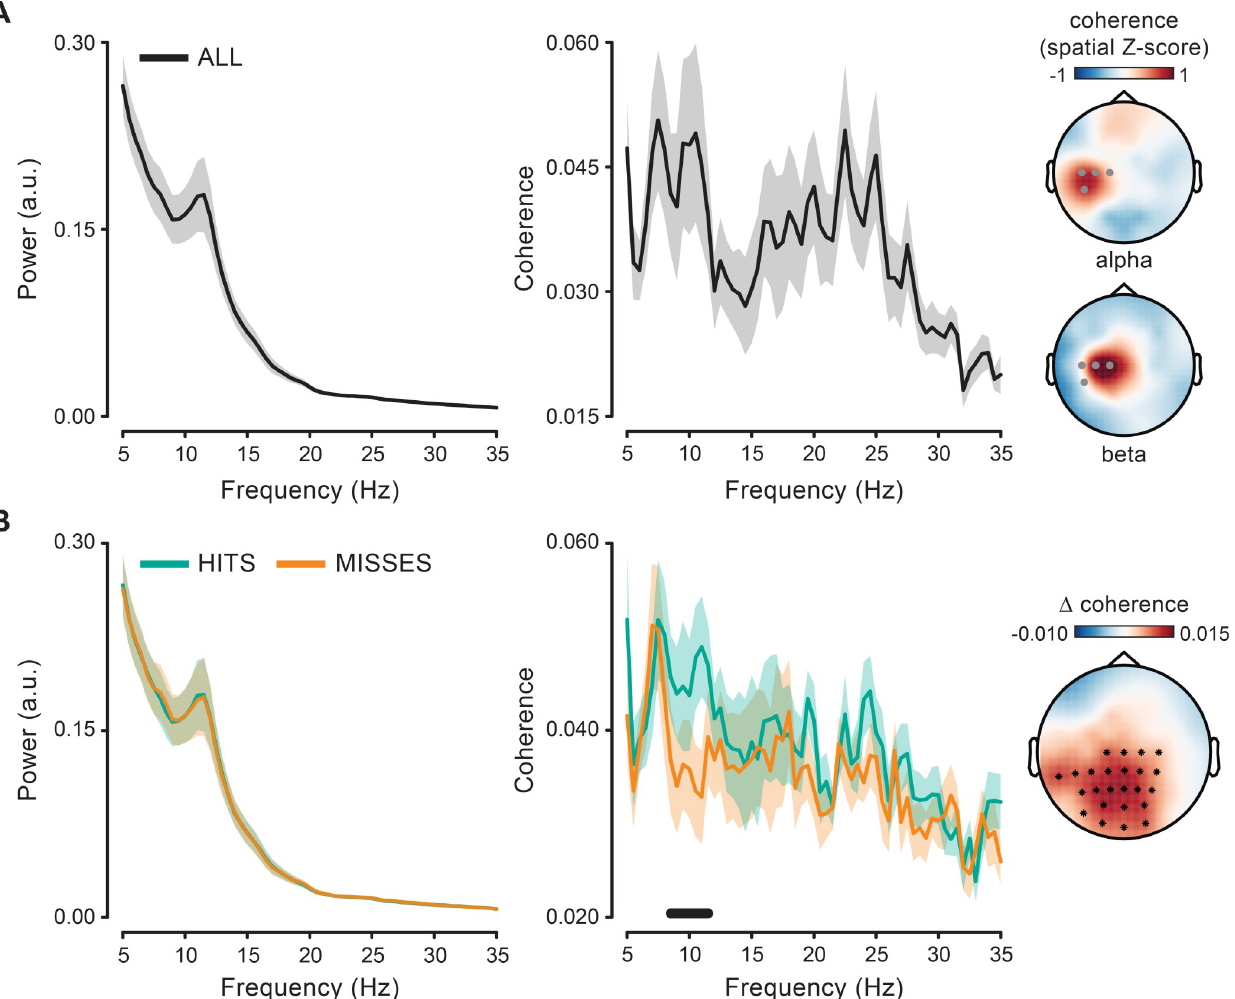
Fig 3. Spectral content of prestimulus force and coherence with cortical activity. (A) Force power (left) and coherence (middle) spectrum with contralateral centroparietal EEG electrodes (C1, C3, C5, CP5; marked in gray in the topographic maps) computed on the prestimulus window ( − 1.6 to 0 seconds). Topographies show coherence in the alpha (9–11 Hz; top) and beta (20–30 Hz; bottom) range. Coherence has been spatially z-scored before averaging across subjects and frequencies by subtracting the individual mean coherence over the electrodes and dividing the result by the standard deviation across the electrodes. (B) Same as in (A) but computed separately for hits- and misses-trials (left, middle). The black horizontal line indicates the frequency interval (8.5–11.5 Hz) belonging to the cluster that survived cluster-based permutation statistics for the hits–misses contrast. Coherence spectra are averaged over the EEG electrodes belonging to the same cluster (evaluated at 10.5 Hz; see black asterisks in the topographic map). Topography shows the hits–misses difference in coherence averaged over the cluster frequency interval (8.5–11.5 Hz). For the underlying data, see https://osf.io/VSZCB/. a.u., arbitrary units; EEG,